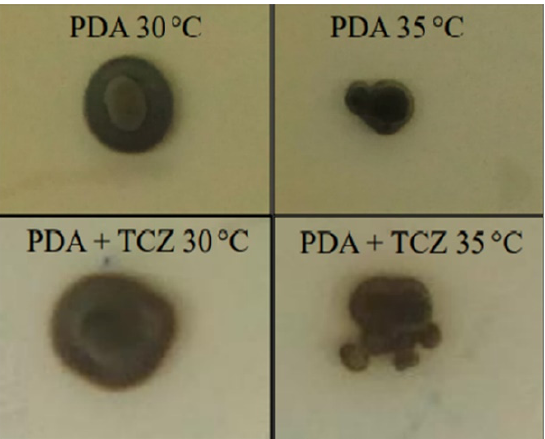
Figure 1. Melanin inhibition in the presence of tricyclazole. The strain Fonsecaea pedrosoi 19889 was grown on potato dextrose agar (PDA, upper panels) and on PDA supplemented with 8 mg/L tricyclazole (TCZ, lower panels), at 30 °C (left panels) or 35 °C (right panels). The other strains present similar growth under these conditions.